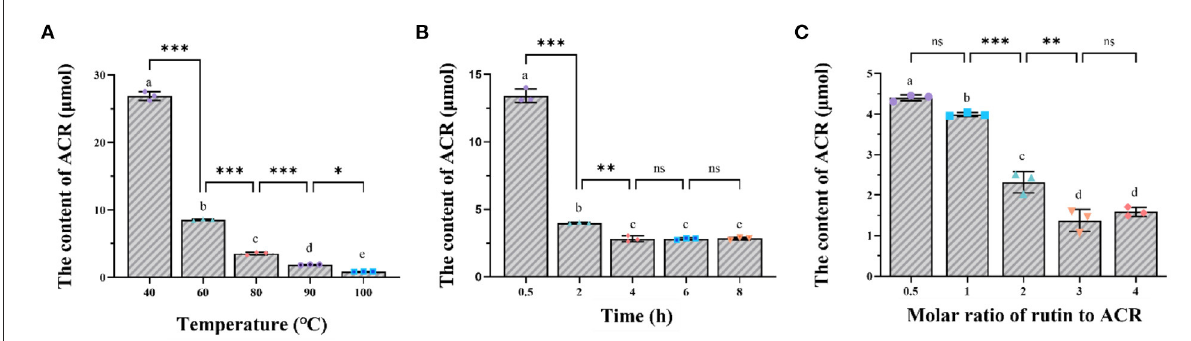
FIGURE1 The impact of (A) temperature, (B) reaction time, and (C) molar ratio of rutin to ACR on the elimination of ACR by rutin. *: p < 0.05; **: p < 0.01; ***: p < 0.001; ns, not significant.